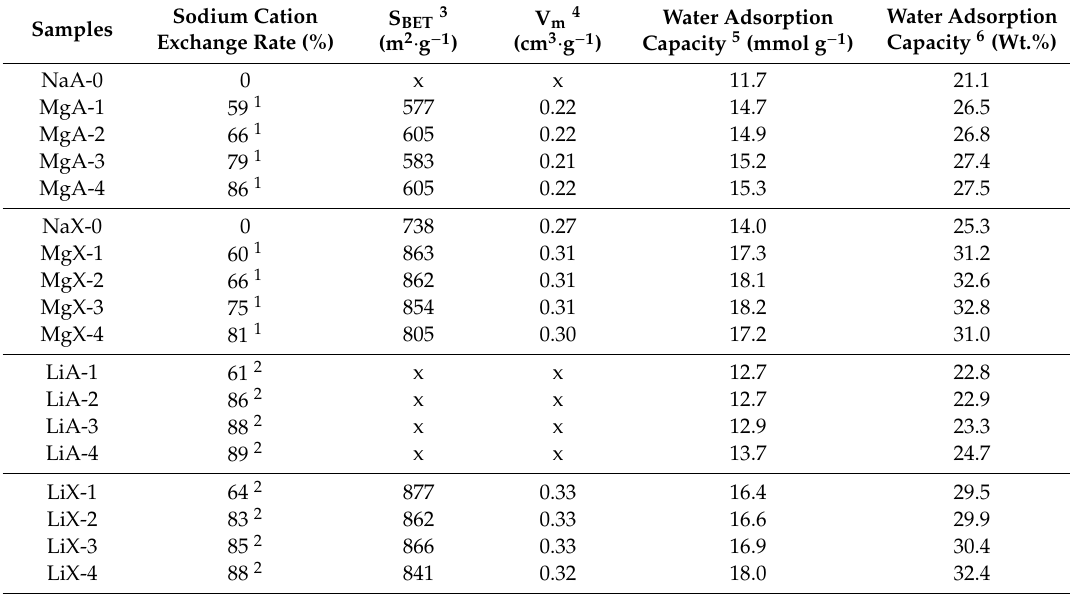
Table 5. Rate of exchange (Negative charges of the framework compensated by the new cation), BET surface area (S BET ), microporous volume (V m ) and water adsorption capacity for LTA-type and FAU-type zeolites modified by Li + and Mg 2 +